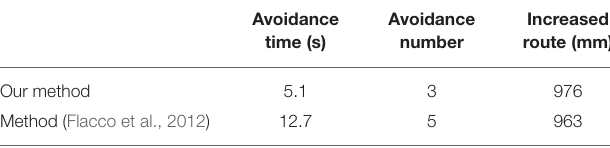
TABLE 2 | Avoidance results of our method and method (Flacco et al.,